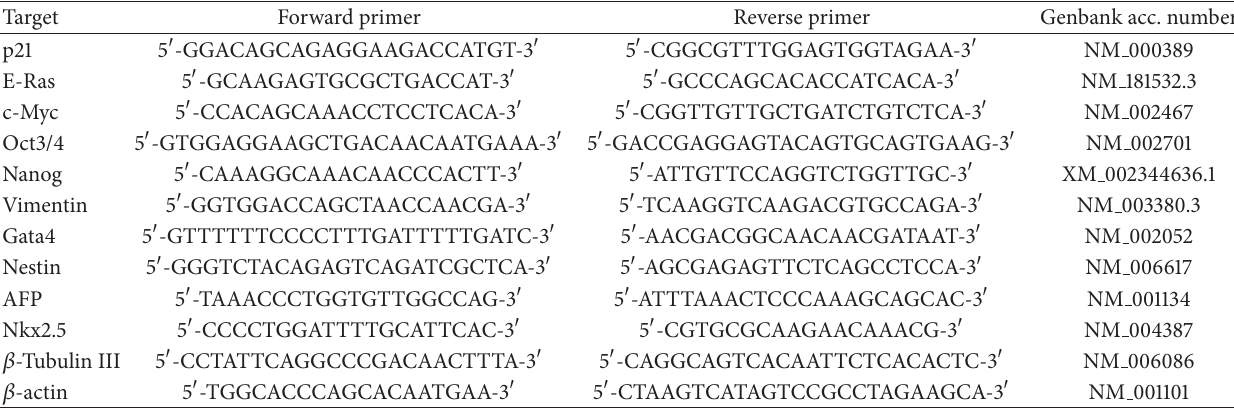
Table 1: Real-time PCR primers used in the